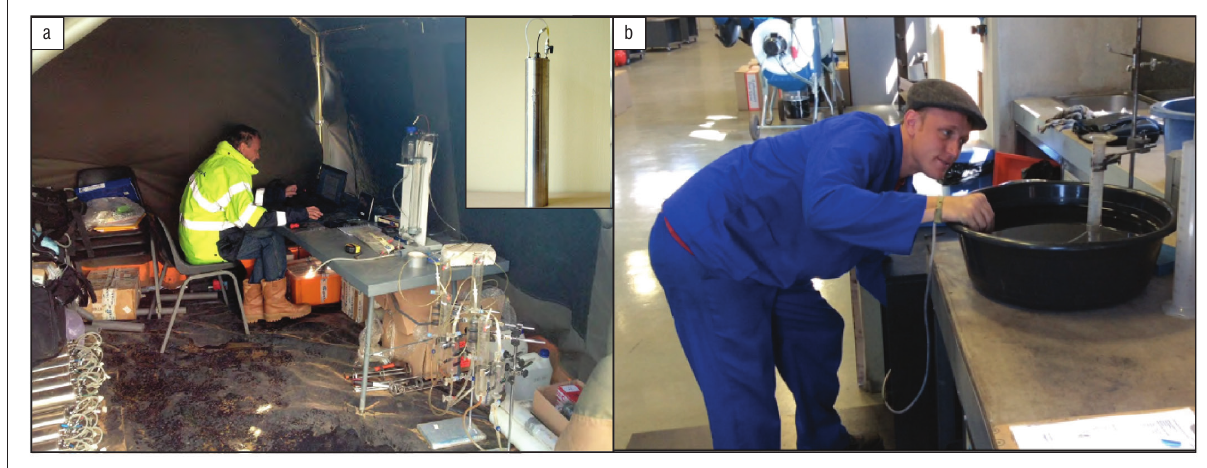
Figure 3: (a) Geokrak’s desorption field laboratory at the KZF-01 drill site. The inset shows a leak-tight stainless steel desorption canister. (b) Measurement of residual gas content of a milled shale sample at Latona Consulting’s Johannesburg